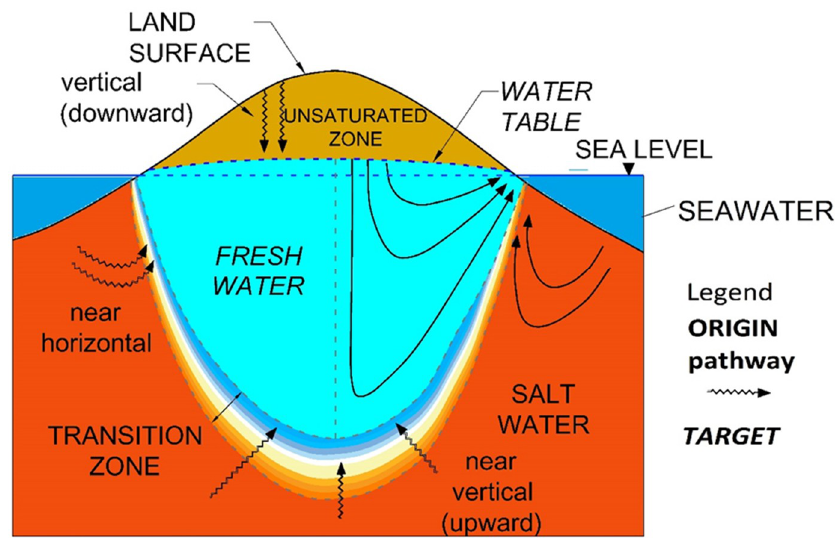
Figure 1. Schematic section of the coastal aquifer of an island (exaggerated vertical scale): origin, pathway, and target of pollution/salinization sources.